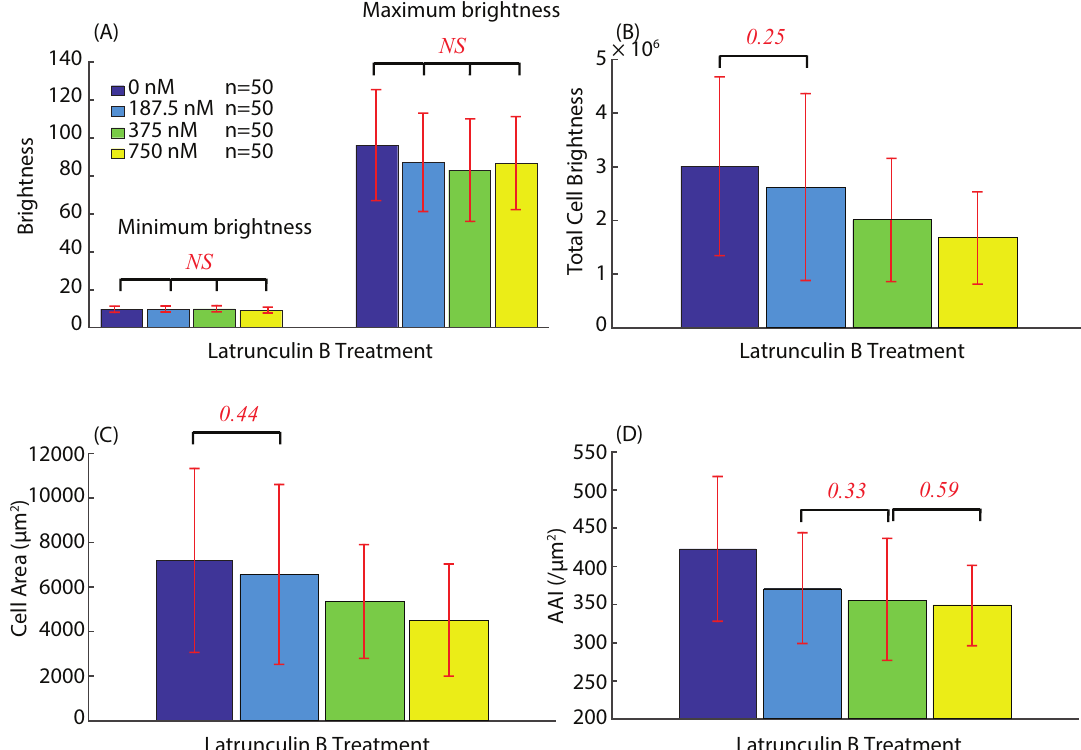
Figure 9. F-actin cytoskeleton intensity quantification result for each treatment condition: ( A ) the minimum brightness ( n 1 ) and maximum brightness ( n 2 ); ( B ) the total cell brightness; ( C ) the detected F-actin cell area; and ( D ) average actin intensity (AAI), respectively. For the untreated cells, AAI = 423 ± 96/ µ m 2 , and the treated cell had AAI = 371 ± 74/ µ m 2 , AAI = 356 ± 82/ µ m 2 , and AAI = 348 ± 54 µ m 2 for the treatment concentrations of 187.5 nM, 375 nM, and 750 nM, respectively. n = 50. Student’s t -test was performed to analyze the statistical difference: the quantification results obtained from each treatment condition were compared with respect to that from other three treatments, respectively. A p < 0.05 was yielded for each comparison, unless otherwise denoted in the figure (with p -values in red italic font). NS: not